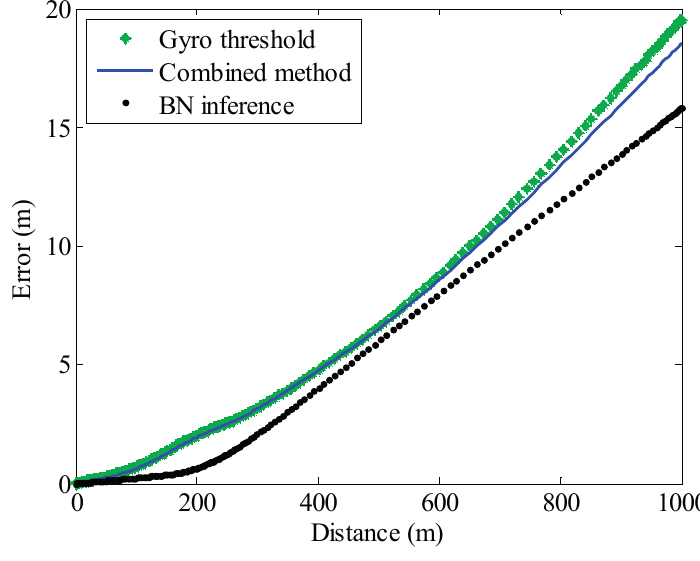
Figure 14. Average horizontal error by PINS/EKF based on different ZV